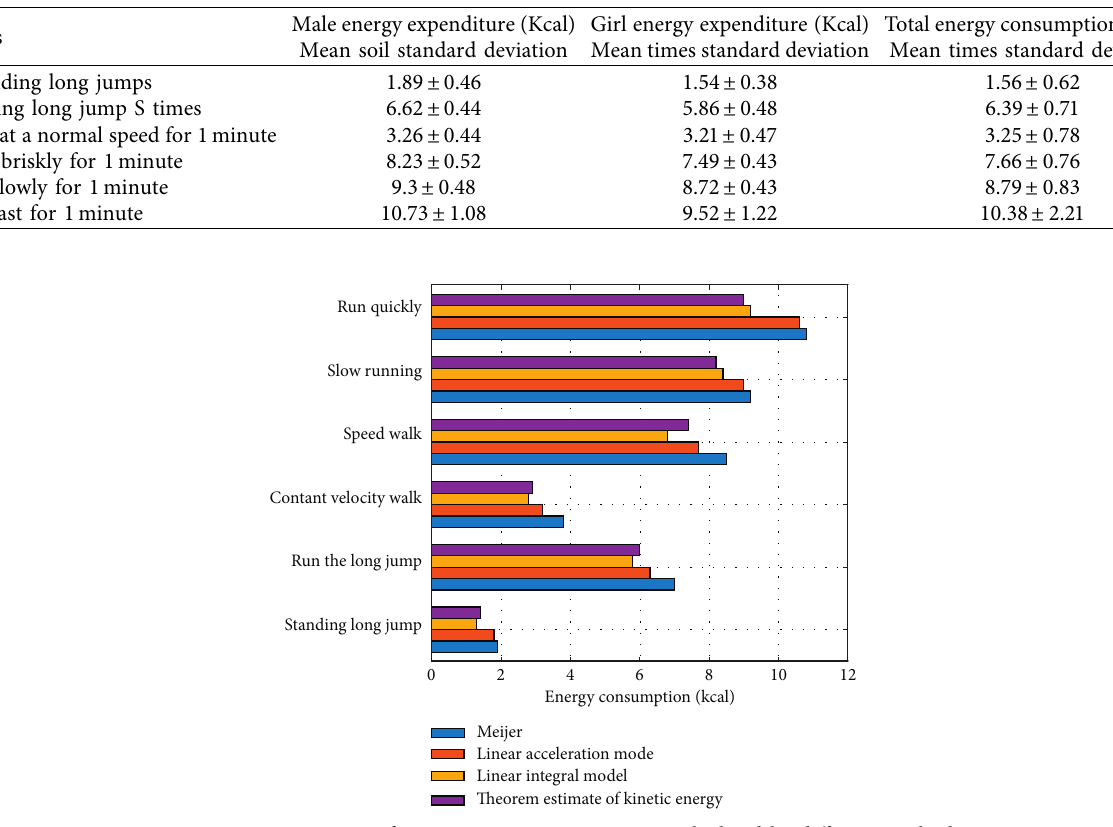
Table 4: Estimation of students’ energy consumption by linear acceleration model.